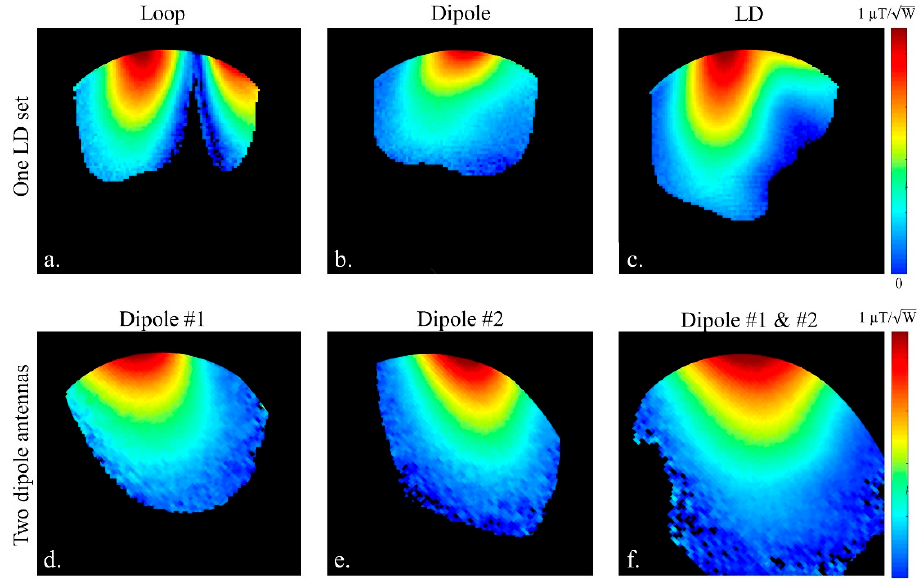
Figure 3. Experimental B 1+ efficiency comparison between an LD set and two dipole antennas with 4 cm circumferential center-to-center distance between the channels. Each individually driven B 1+ efficiency map by a loop ( a ) and a dipole ( b ) of the LD set was acquired. And, in figure ( c ), both two elements of the LD set were driven simultaneously and normalized by the net input power for the comparison of the B 1+ efficiency. For the comparison with the LD set, B 1+ efficiency maps of each dipole antenna ( d , e ) of two dipole antennas and two activated dipole antennas ( f ) were also obtained. Each map was acquired at the center slice of the phantom in the transaxial